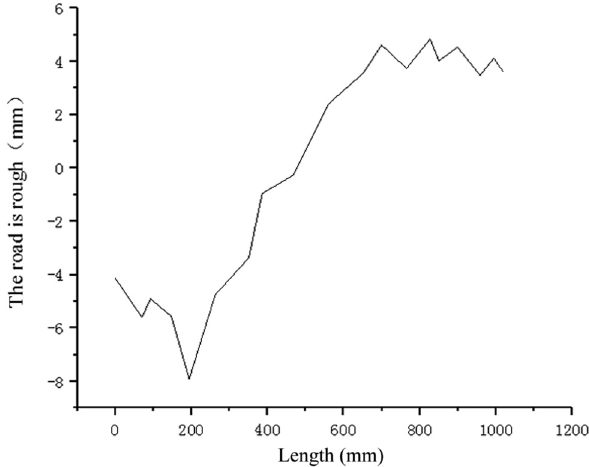
Figure 4: Simulation results of class A pavement roughness using the FD process model based on